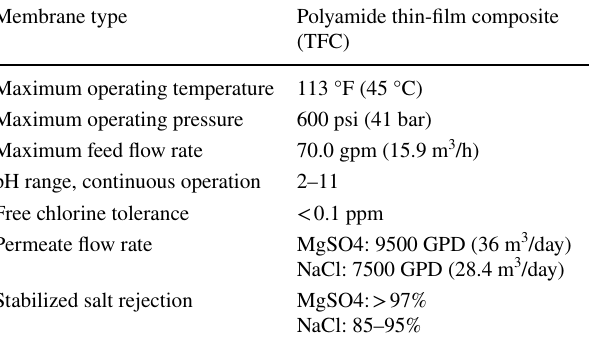
Table 2 Characteristics of raw